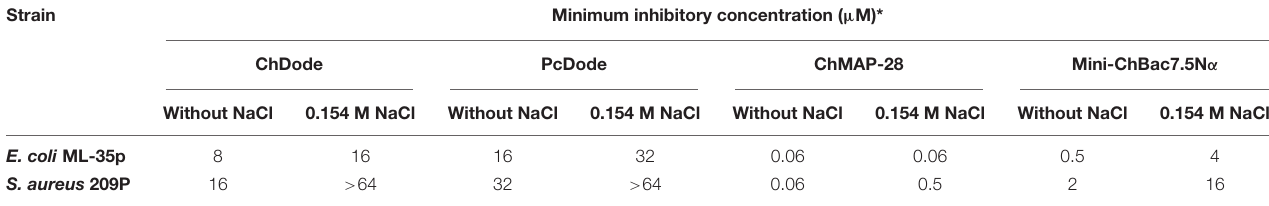
TABLE 1 | Antibacterial activity of goat cathelicidins and whale cathelicidin-1 PcDode.